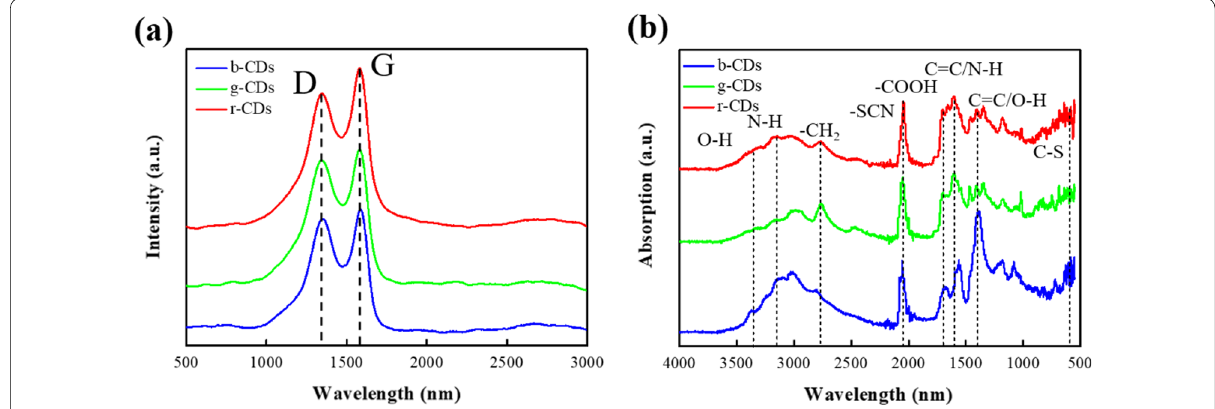
Fig. 3 Raman spectroscopy ( a ) and FT-TR spectroscopy ( b ) of the three selected CDs